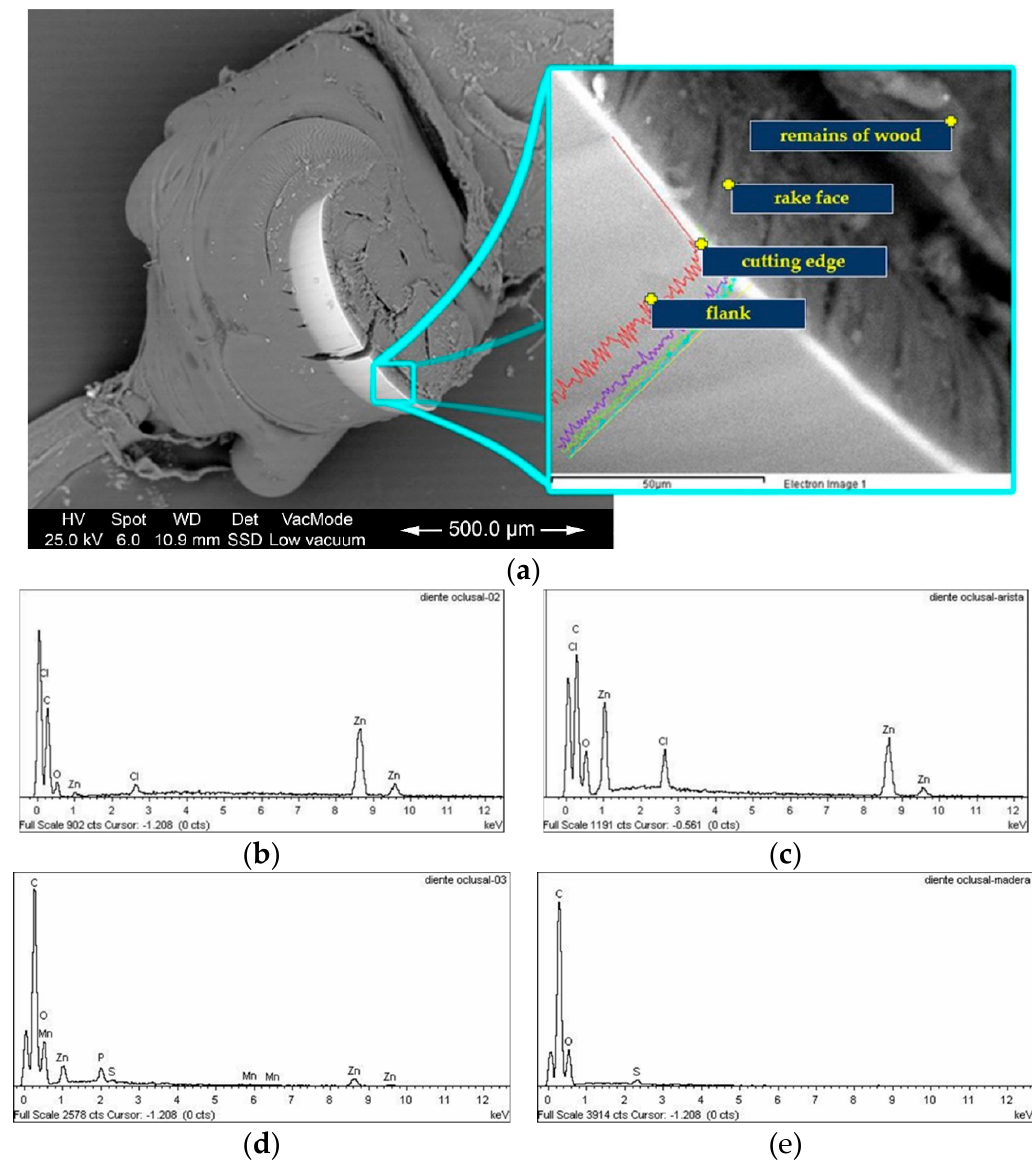
Figure 4. Semiquantitative chemical microanalysis points through X-ray wavelength dispersion spectrometry. ( a ) Location of the analysis points on the cut surfaces; ( b ) plots of the chemical microanalysis results of the flank of the jaw from the ( c ) cutting edge, ( d ) rake face of the jaw and ( e ) remains of wood in the jaw.